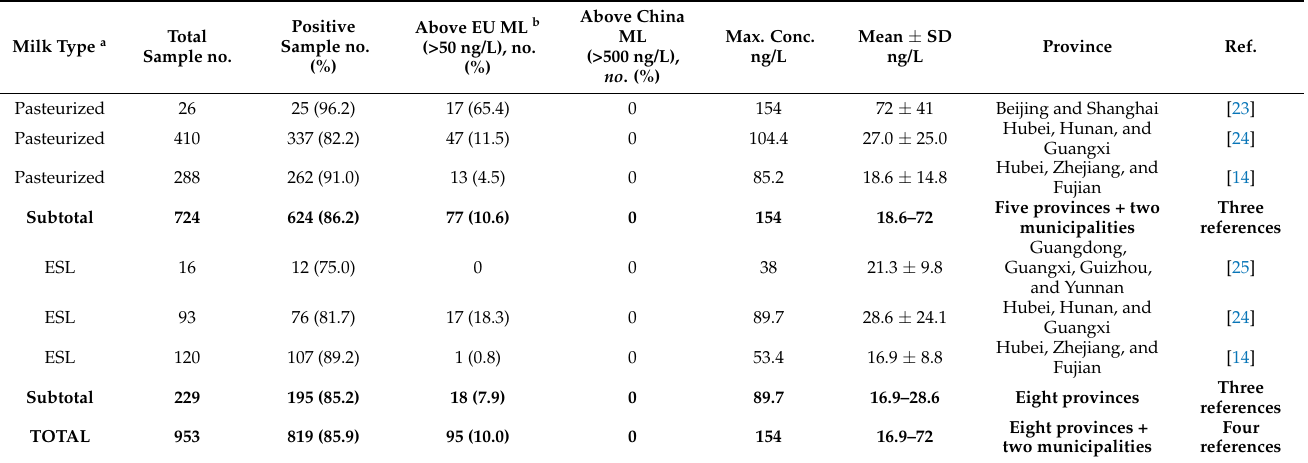
Table 3. Review of the occurrence of AFM1 in pasteurized milk and ESL milk in